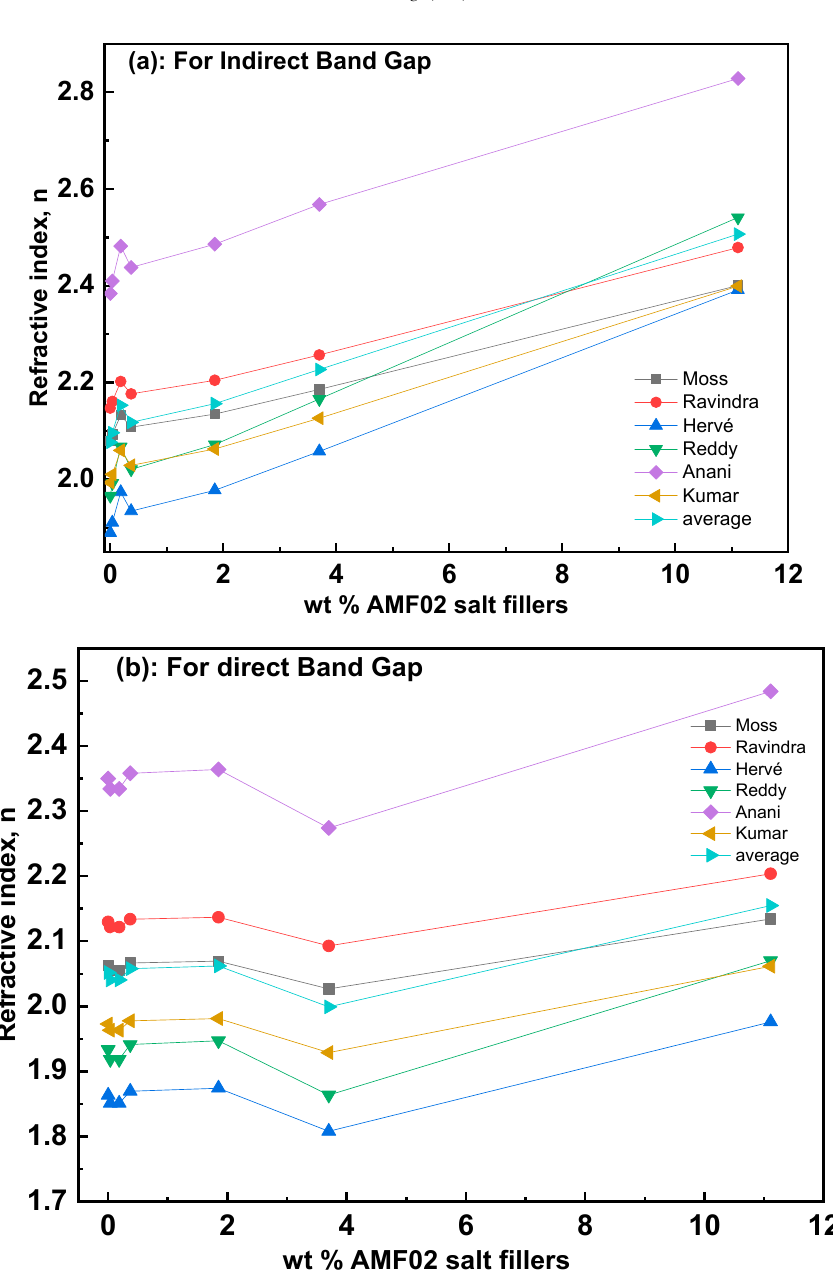
Figure 8. The calculated refractive index ( n ) values using a different model for both ( a ) indirect and ( b ) direct bandgap for pure PVA and AMF02/PVA novel PCCEFs. With Reddy’s relation and for both indirect and indirect bandgap transition, the ob- tained n values for AMF02/PVA novel PCCEFs are illustrated in Figure 8a,b. The gained n values are denoted in Tables 2A,B. The refractive index increases for indirect bandgap transition (i.e., for direct bandgap) and rises in AMF02 salt filler. Similar results were re- ported by other works [9,37]. The attributes of the acquired refractive indices disagree with each relation, which is advantageous considering the intention for the AMF02/PVA new PCCEFs to be potential optical device candidates. The Anani et al. relationship has recently been computed using the equation [38]: